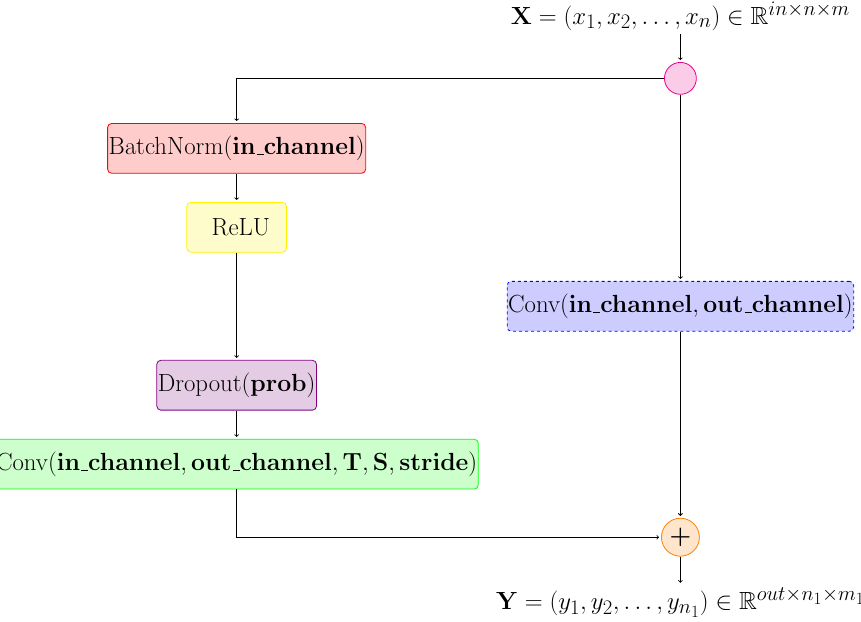
Figure 7. Architecture of a TCN type unit. The convolutional layer of the blue block is used only if = out _ channel . T represents the size of the temporal window, and S represents the size of in _ channel (cid:54) = 1 then n 1 < n and m 1 < m , where n represents the number of frames the spatial window. If stride (cid:54) and m represents the number of joints.